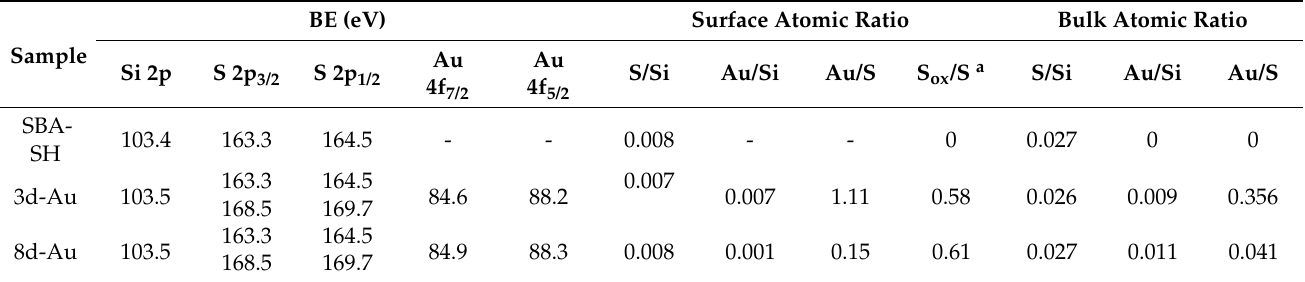
Table 3. XPS core-level binding energies and atomic ratios.